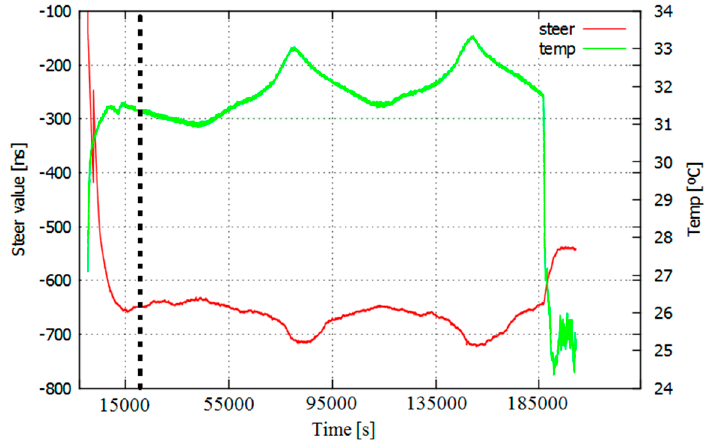
Figure 1 . CSAC steering value (red) and room temperature (green), 56 h of data acquisition. The vertical ticked line mark the end of the disciplining process.